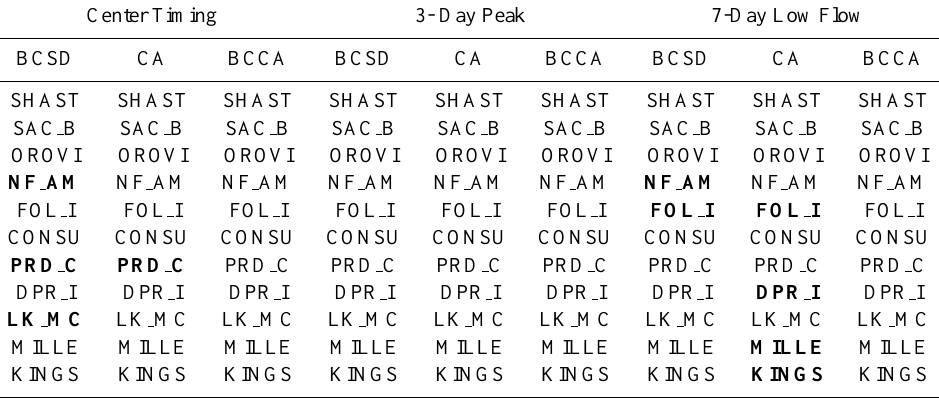
Table 3. Statistical test results for BCSD, CA, and BCCA for daily flow measures. A gauge name in bold face indicates that the distribution of 22 values for downscaled streamflow differs from the observed distribution, based on a Kolmogorov-Smirnov 2-sample test (at p = 0 . 05). Hence, non-bold face indicates the downscaling method produces values statistically indistinguishable from observations.